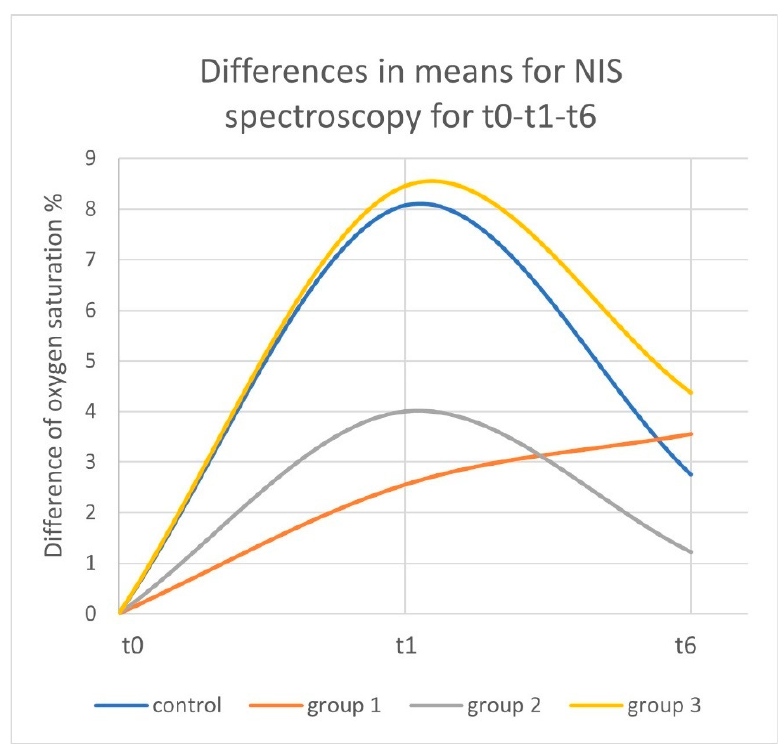
Figure 4. Differences of the means in the oxygen saturation percentage compared to t0 at t1 and t6 measured by near-infrared spectroscopy.